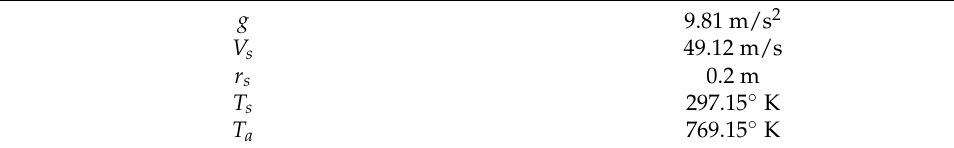
Table 10. Defining parameters for dispersion